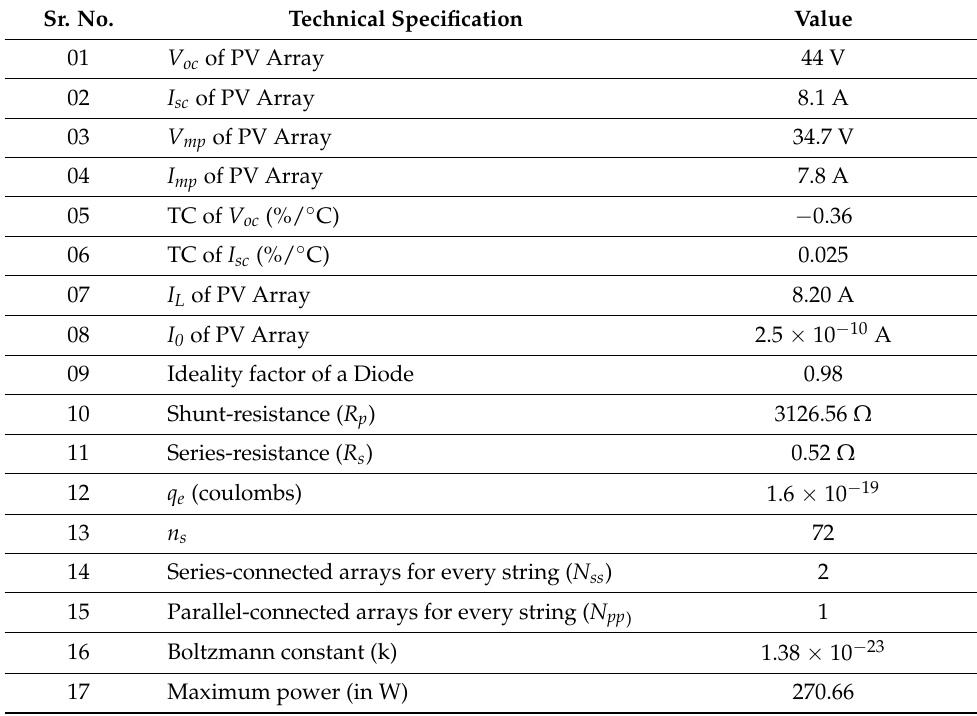
Table 1. Vikram Solar PV Array Technical Specifications.